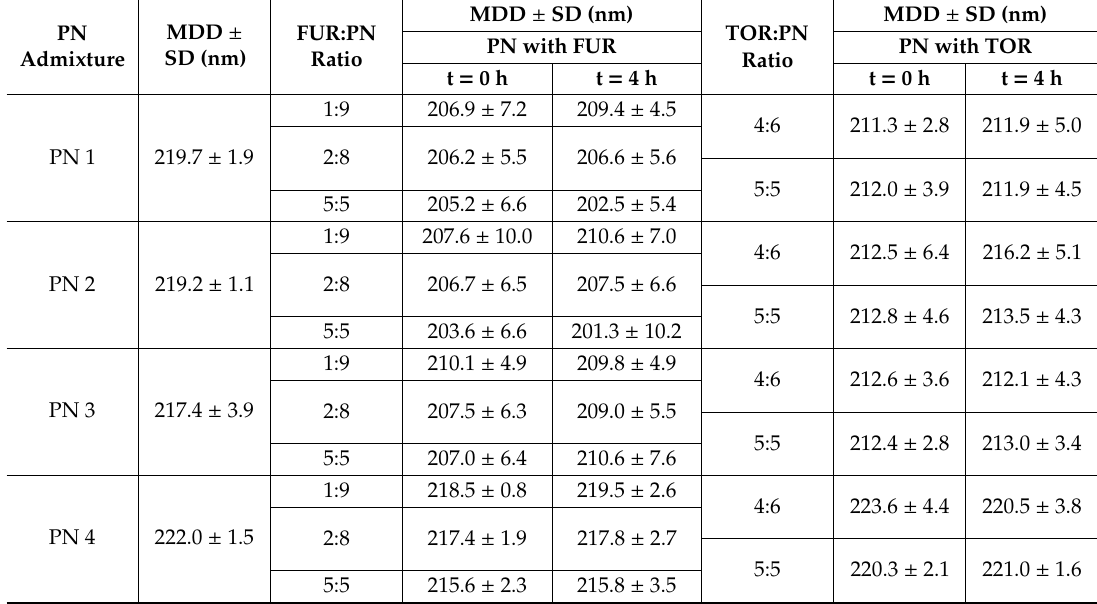
Table 2. Mean droplet diameter (MDD) of standard parenteral nutrition with and without furosemide and